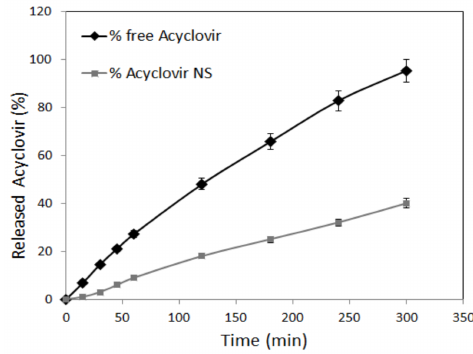
Figure 2. In vitro release kinetics of acyclovir from the drug aqueous solution and from the chitosan acyclovir NS.